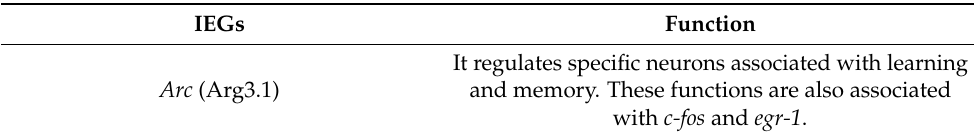
Table 1. Classification of IEGs and their